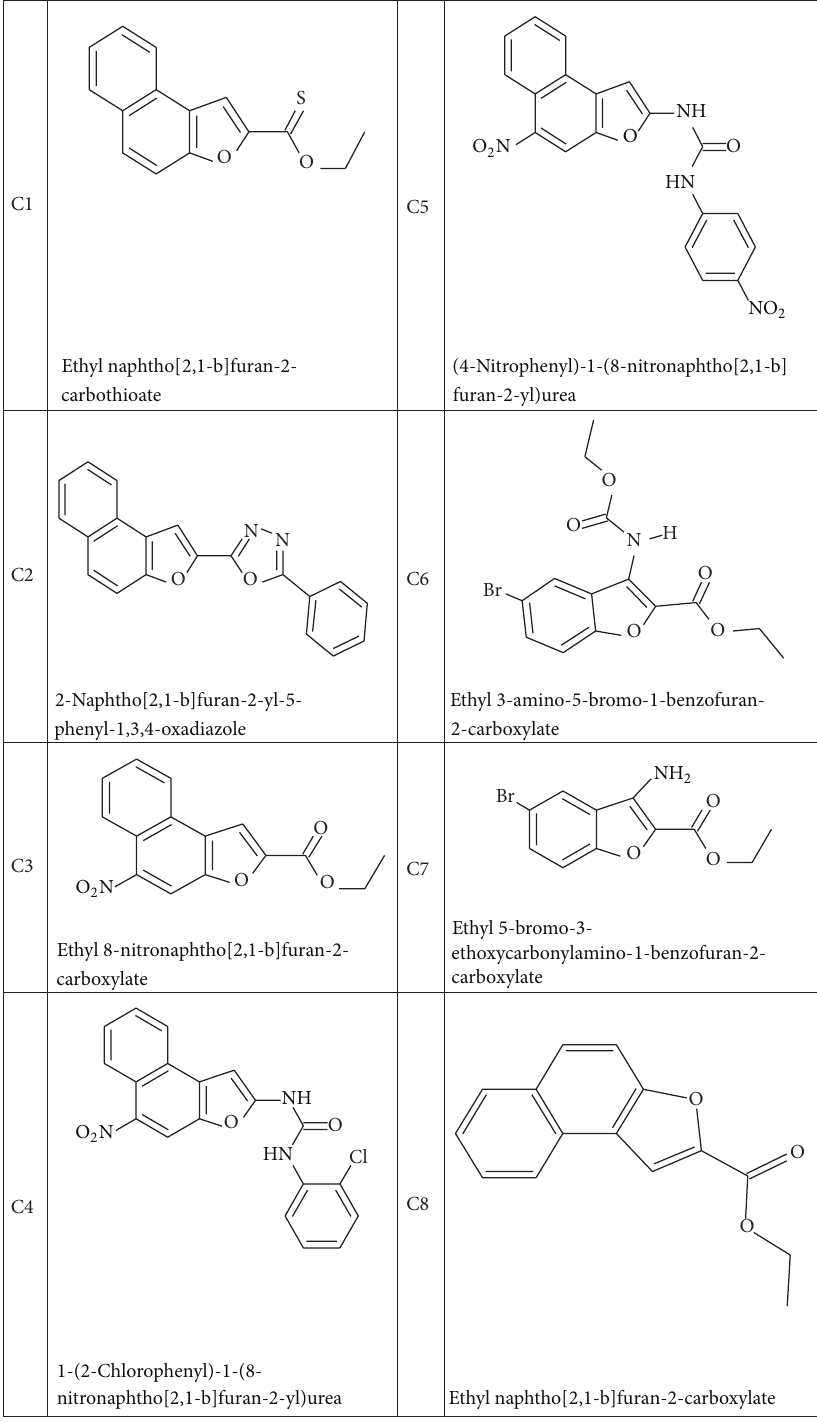
Figure 3: Benzofuran and naphthofuran derivatives structures used in docking studies.